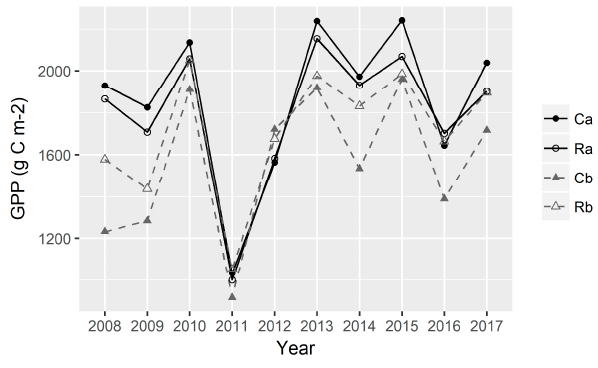
Figure 8. Annual sum of GPP in different treatments.